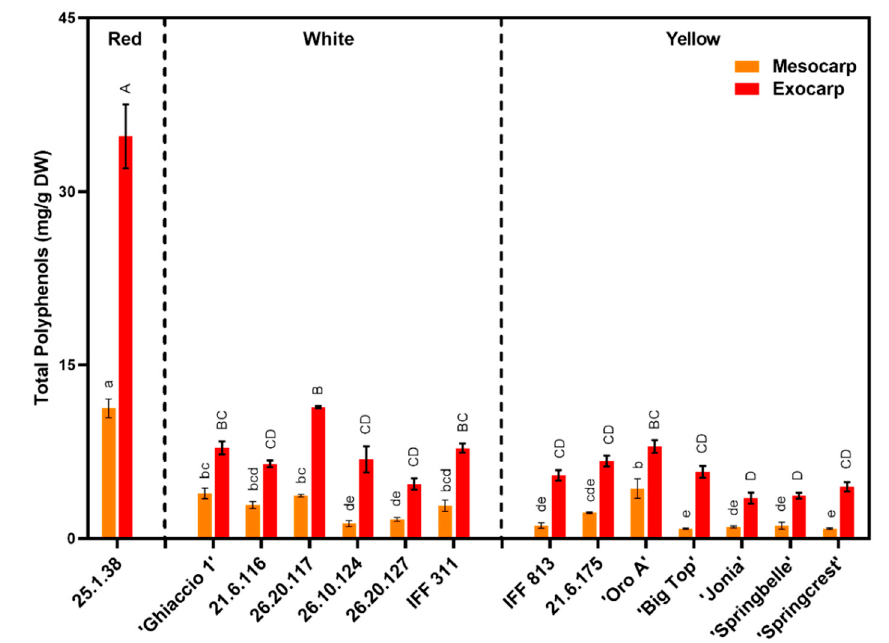
Figure 4. Total phenolic concentration (sum of all categories listed in Table 3) identified in peach/nectarine mesocarp (in orange) and exocarp (in red) tissue sample types across all commercial cultivars and breeding accessions assessed in 2007. Cultivars and accessions are presented divided by flesh color. Tukey (HSD) test for post-hoc mean comparisons. Columns with the same letter above indicate non-significance at p < 0.05. Means ± S.E. displayed.